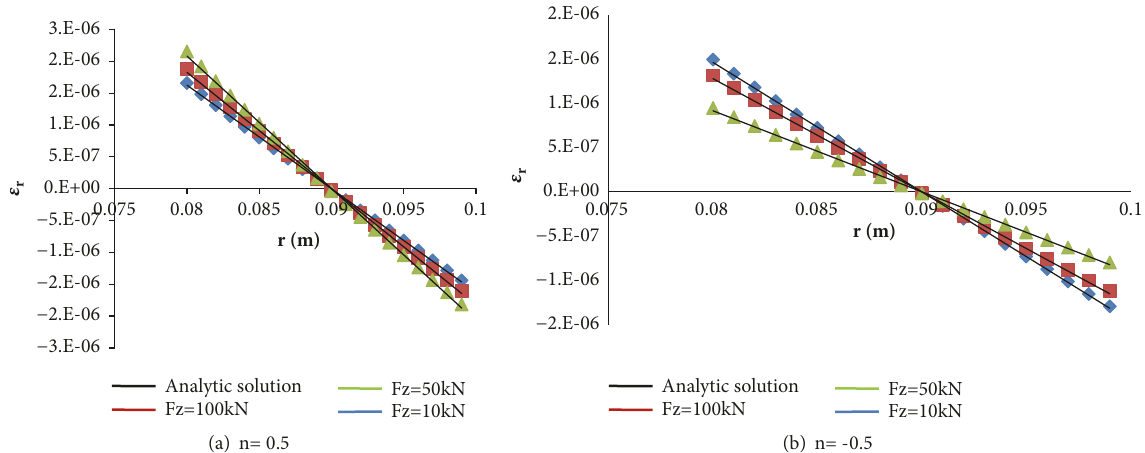
Figure 3: Radial strain 𝜀 𝑟 as a function of the radial coordinate r: (a) for n=0.5 , (b): n=-0.5 .